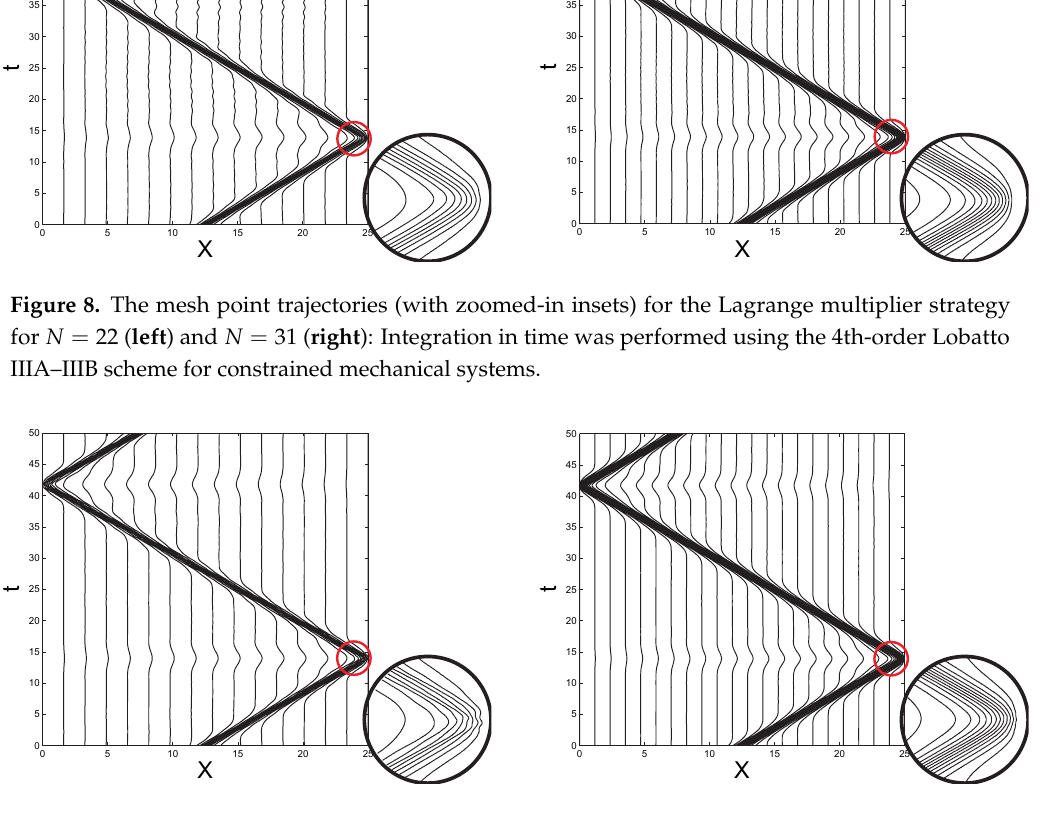
Figure 9. The mesh point trajectories (with zoomed-in insets) for the control-theoretic strategy for N = 22 ( left ) and N = 31 ( right ): Integration in time was performed using the 4th-order Gauss scheme. Integration with the 4th-order Lobatto IIIA–IIIB yields a very similar